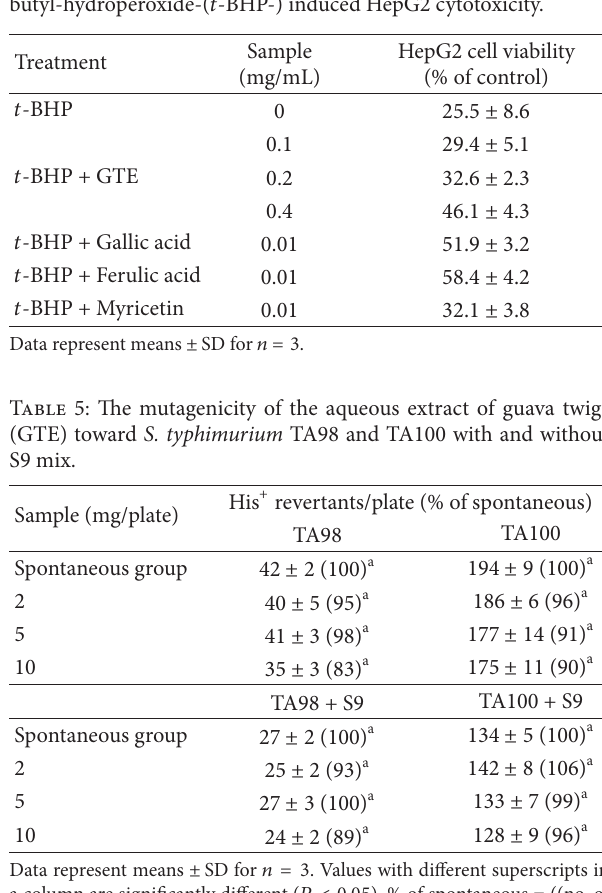
100.enumberofspontaneousrevertantswasdeterminedwithoutsamples and mutagens.